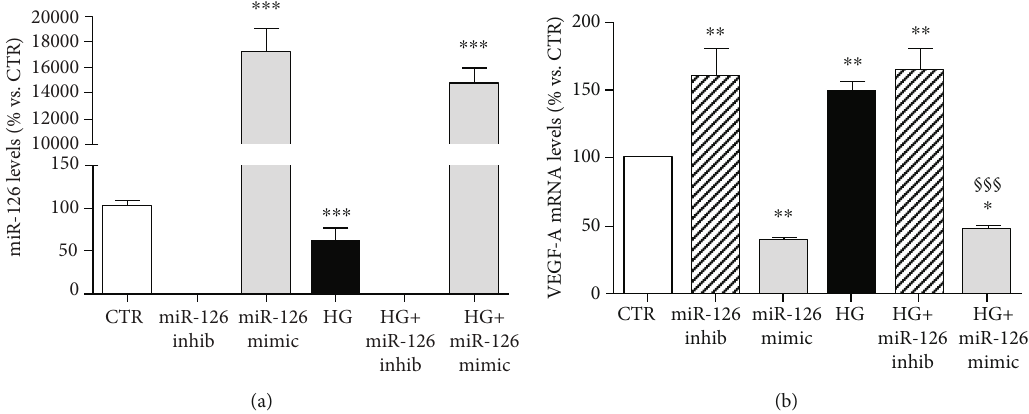
Figure 1: (a) Levels of miR-126 in ARPE-19 cells cultured for 24 hours in standard medium (CTR), silencing (inhib) and upregulating (mimic) miR-126 in control condition and in presence of high glucose (HG). Gene expression was normalized vs. U6 housekeeping gene. (b) mRNA levels of VEGF-A in ARPE-19 cells cultured for 24 hours in standard medium (CTR), silencing (inhib) and upregulating (mimic) miR-126 in control condition and in presence of high glucose (HG). VEGF-A gene expression was normalized vs. β -actin as housekeeping gene. Data are presented as the mean ± SEM of three experiments ( n = 3 ). ∗ p < 0 : 05 , ∗∗ p < 0 : 01 , and ∗∗∗ p < 0 : 001 vs. CTR; $$$ p < 0 : 001 HG+mimic vs. HG.